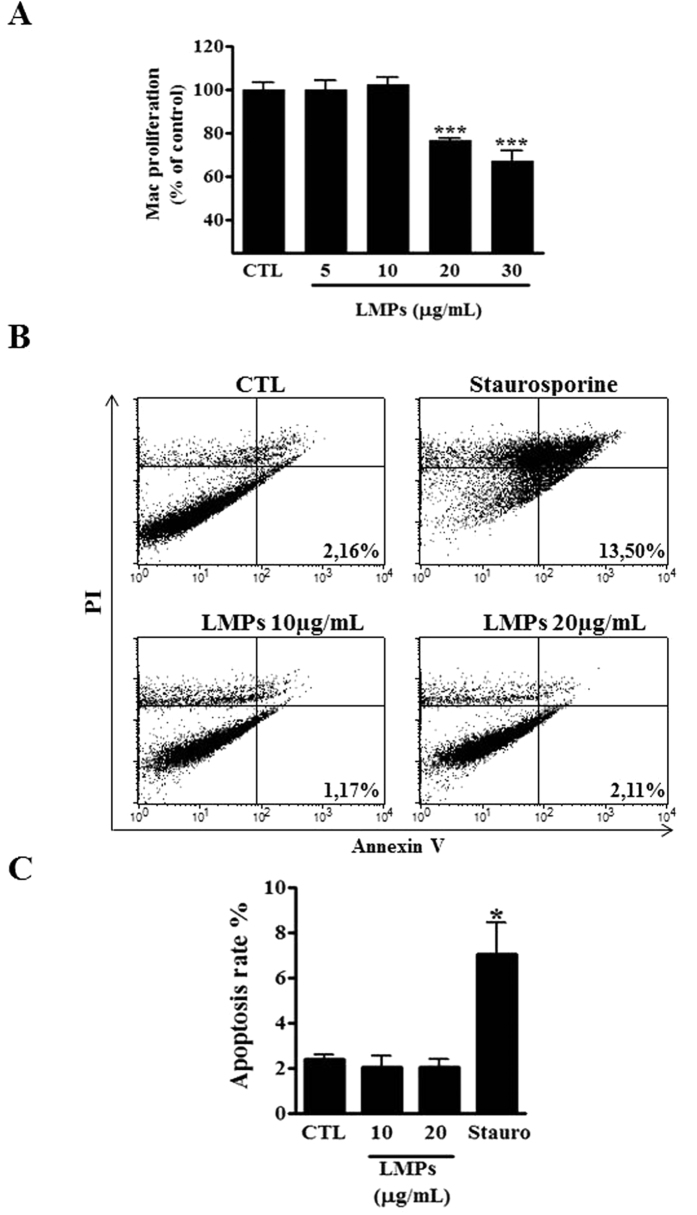
LMPs dose-dependently inhibited macrophages proliferation.(A) Indicated concentrations of LMPs were incubated with macrophages (RAW 264.7) for 24 hours. The proliferation of macrophages was determined using 3H-thymidine incorporation and values were presented as a percentage of control (CTL). ***P < 0.001 vs. CTL. (B) Representative results of flow cytometry analysis of macrophage cell apoptosis after 24-hours of treatment with indicated concentrations of LMPs, or staurosporine (positive control). FACS analysis was performed after macrophages were stained with Annexin-FITC and propidium iodide using Vybrant Apoptosis assay kit. Note that the staurosporin-treated cells undergo apoptosis and become PI+/Annexin V+ in the later stages of apoptosis. No difference is observed in LMPs-treated and control macrophages for Annexin V staining. (C) The apoptosis rates were presented as the percentage of apoptotic cells relative to the total number of cells. Values are means ± SEM. *P < 0.05 vs. CTL. Mac and Stauro indicate macrophages and staurosporin, respectively.